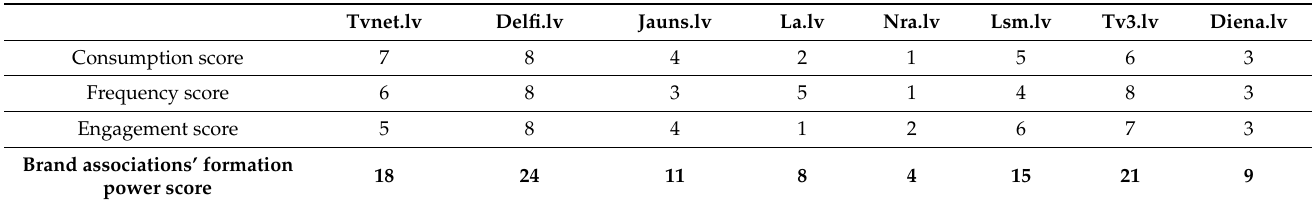
Table 7. The brand associations formation score summary for each of the 8 news media brands, audience 15–24 years old, Latvia,